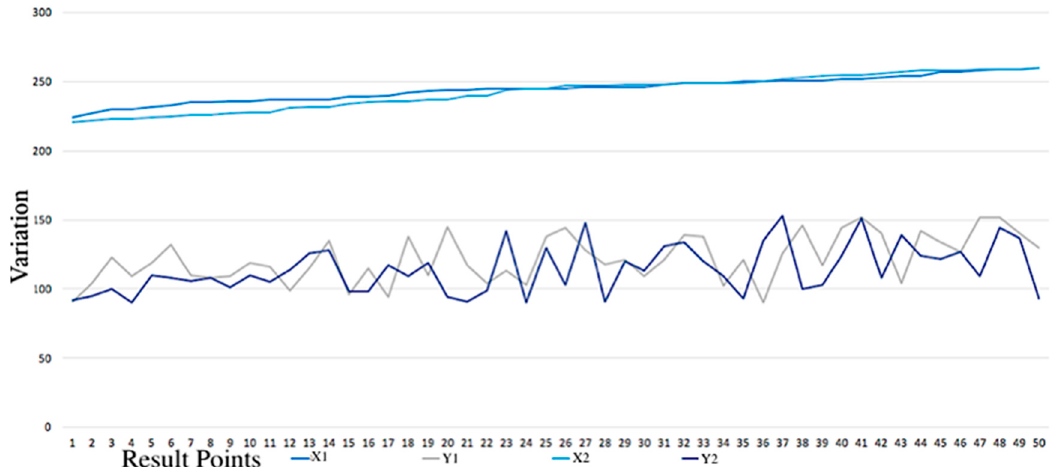
Figure 13. Example of variation of X and Y coordinates of 50 anchor points (out of 238 results). Horizontal numbers present anchor points in each group.